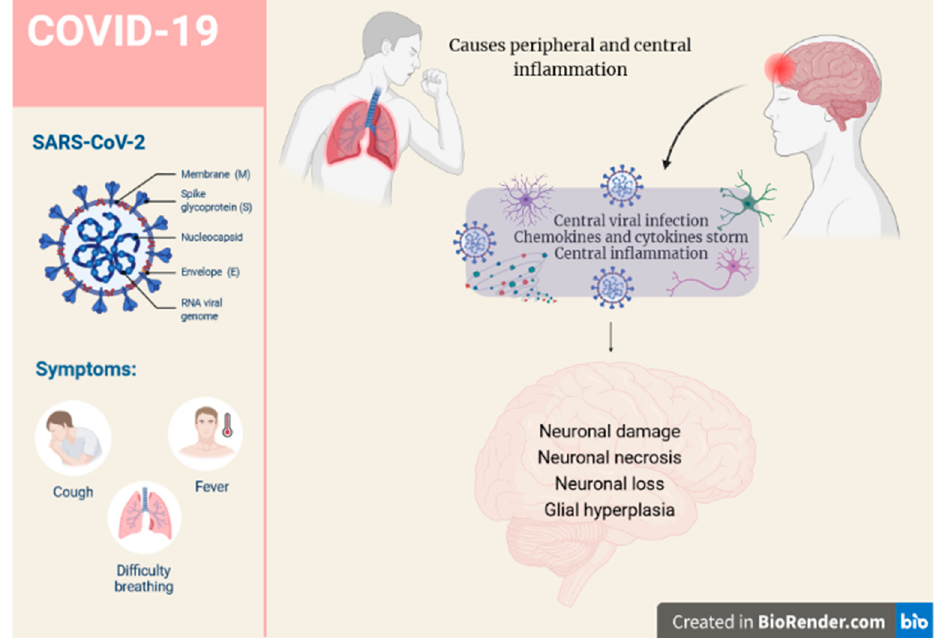
Figure 1. SARS-CoV-2 in human cells. SARS-CoV-2 infection activates humoral and cellular immunity, causing lymphocyte dysregulation and cytokine storm, which contribute to the development of peripheral and central damage.